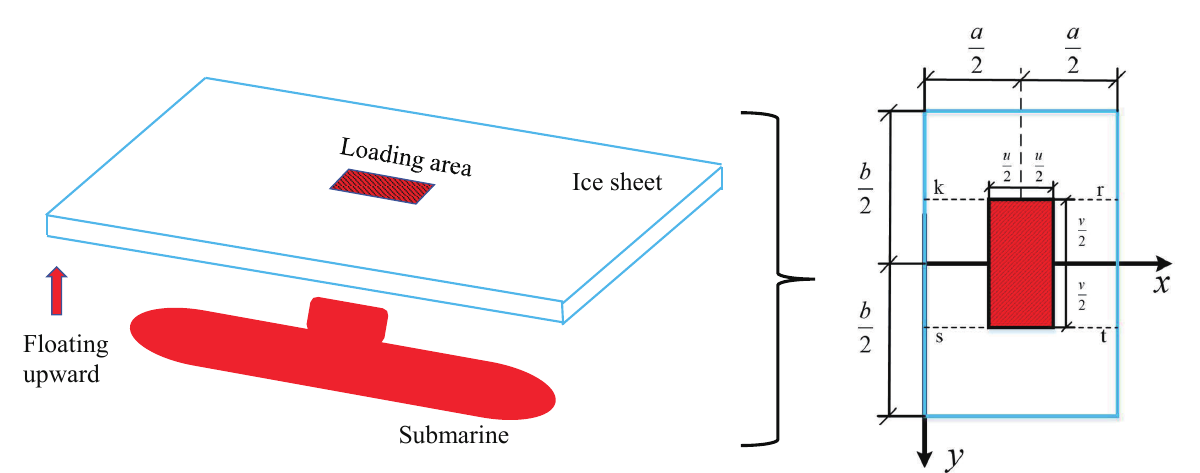
Figure 2. The simplified model for the calculation of ice resistance of control